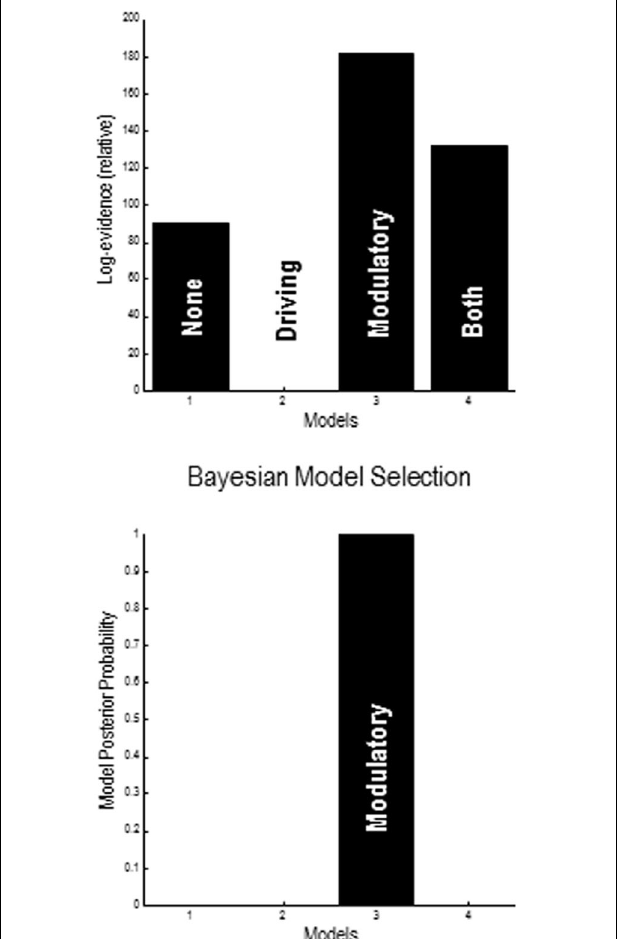
FIGURE 5 | Results of provisional Bayesian model selection. The (free energy approximation) to log evidence was assessed for models with and without validity–dependent differences in top-down driving and modulatory connections. The log evidences (upper panel) show that the model with differences in modulatory connections has the greatest posterior probability (lower panel) . The log evidences are shown relative to the evidence for a null model with no changes in either driving or modulatory backward connections.